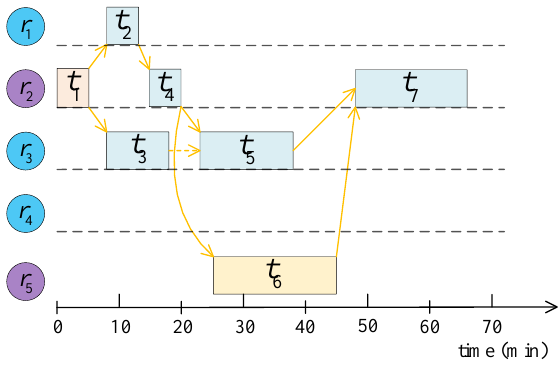
Figure 3. Example of consolidating tasks in different resources.